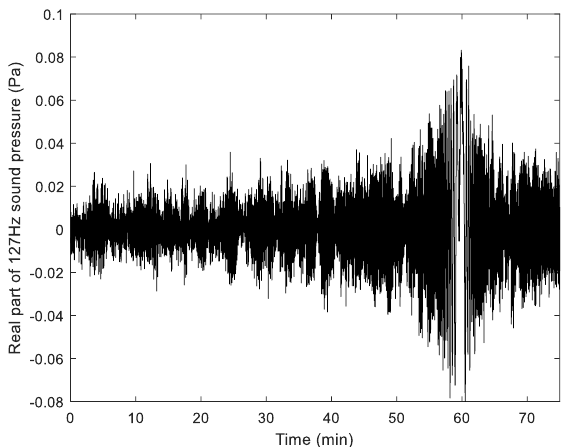
Figure 9. Variation of the real part of 127 Hz sound pressure during the 75 min of the experiment.